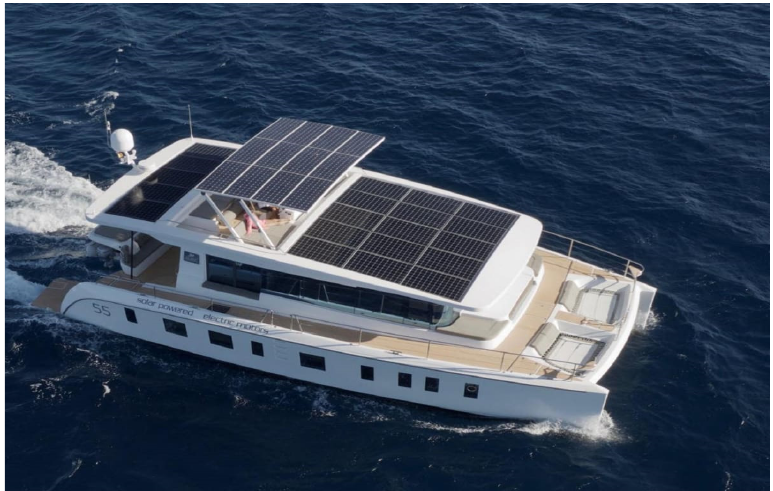
Figure 1. Solar powered